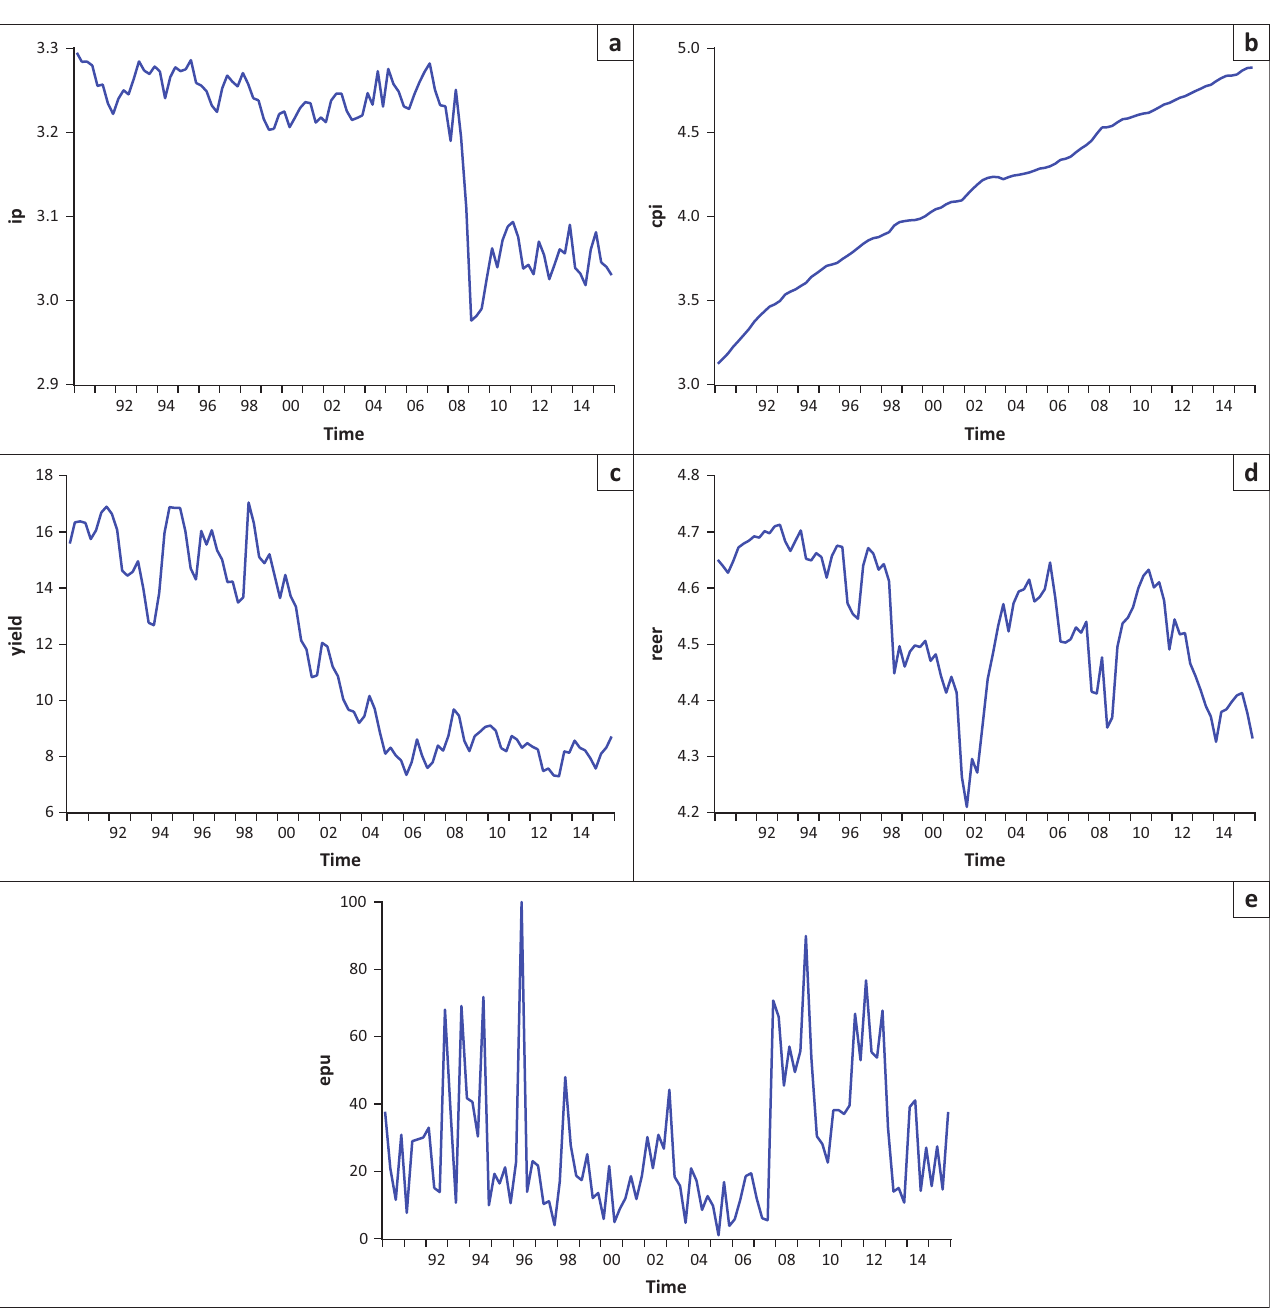
FIGURE 1-A1: Plot of variables used in analysis: (a) ip; (b) cpi; (c) yield; (d) reer); (e) epu.